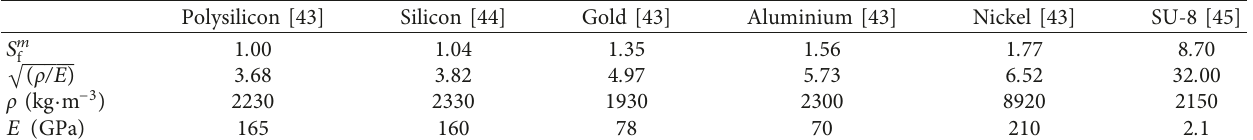
Table 4: Material properties comparisons.